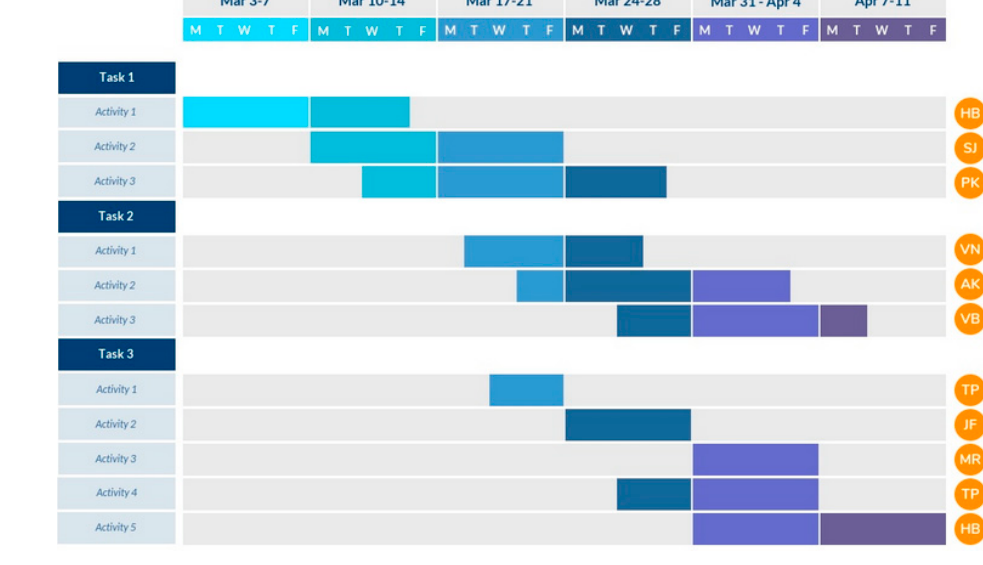
Figure 14. Process planning guideline.